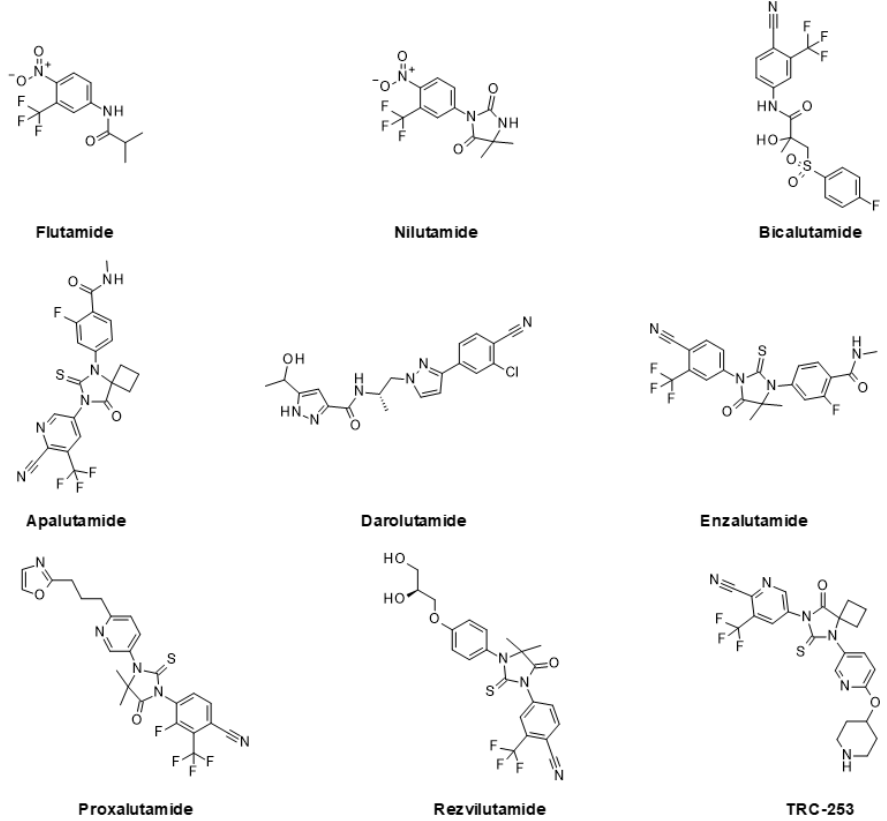
Figure 2. AR inhibitors launched or in late-stage clinical trials.